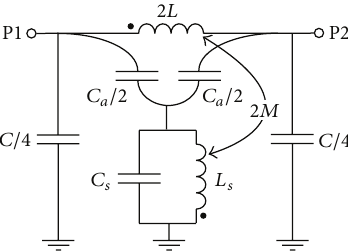
Figure 14: Proposed equivalent circuit model (unit cell) of the CPW loaded with arbitrarily oriented SRRs ( 𝐶 𝑎 = 0 for 𝜙 = 0 ∘ ). The magnetic wall concept has been applied. From [46], reprinted with